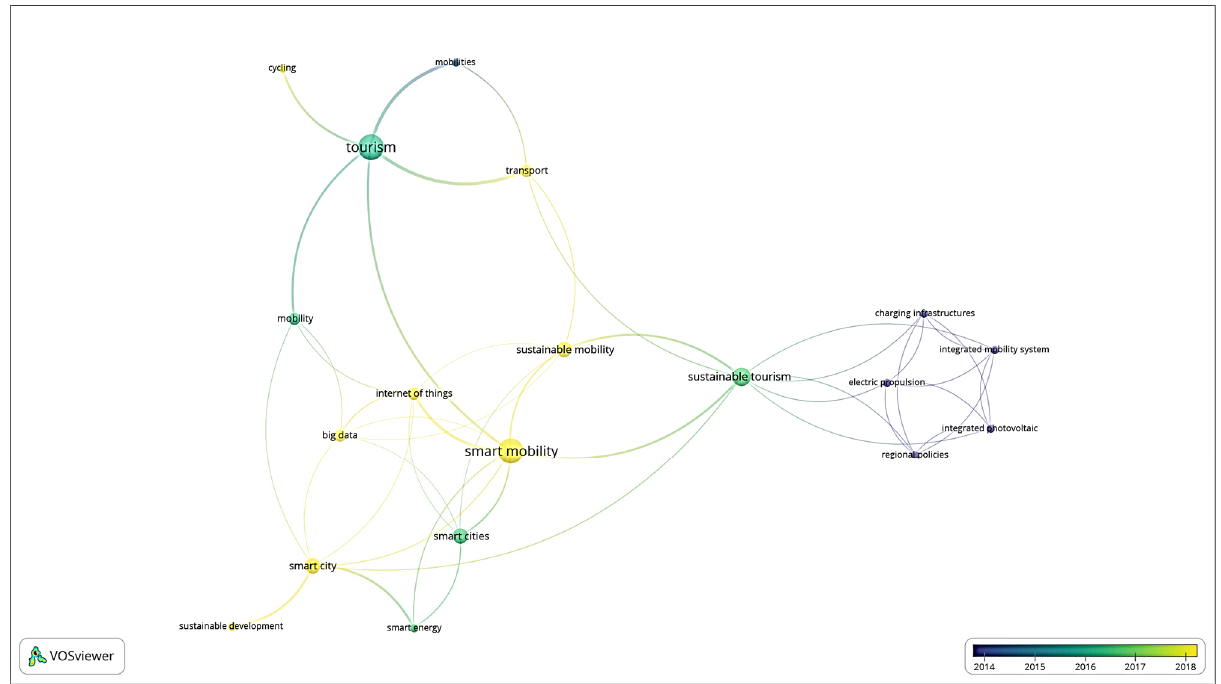
Figure 1. Co-occurrence of author keywords (overlay visualization).